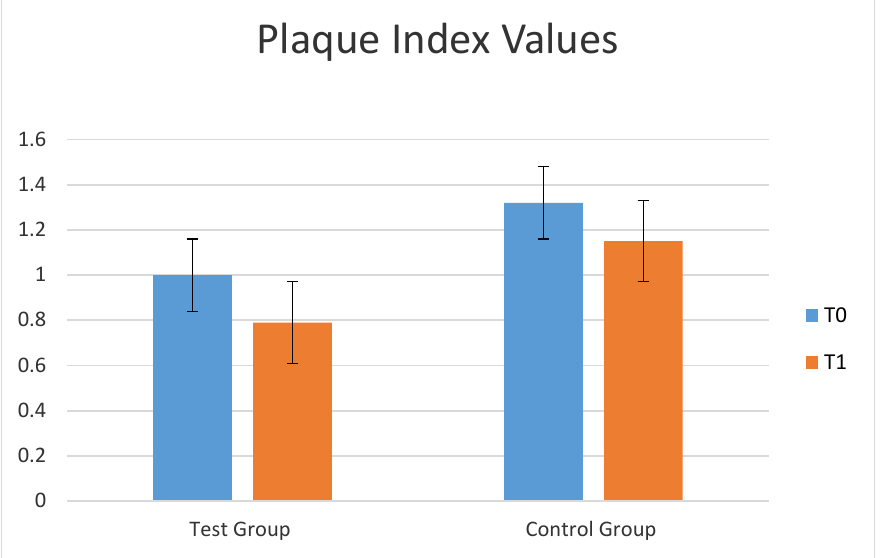
Figure 1. Plaque Index (score) evaluated in both test and control groups at two different time points (T0–T1).